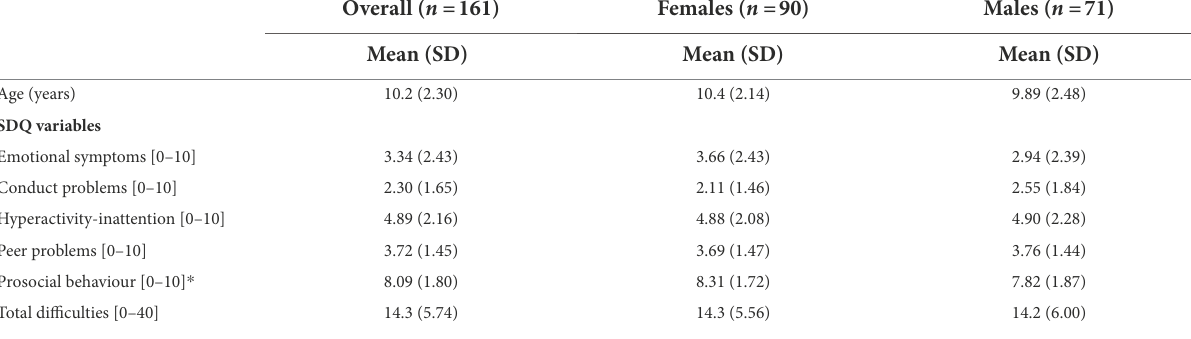
TABLE 1 Characteristics of the